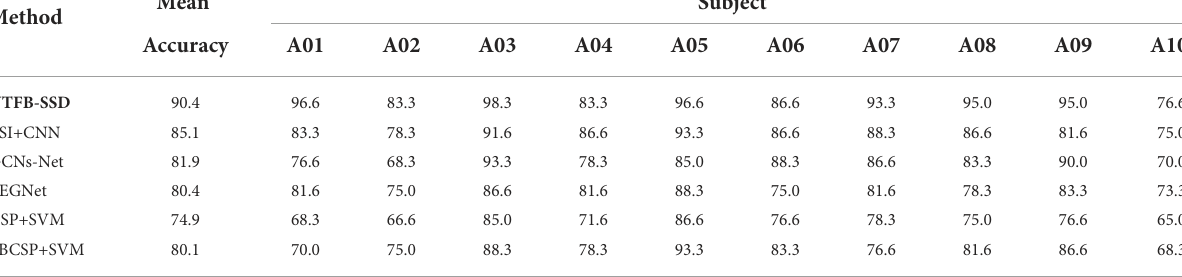
TABLE 2 Comparison of the accuracies (%) between the proposed algorithm and other methods on the in-house dataset (with stimulation). Mean Method